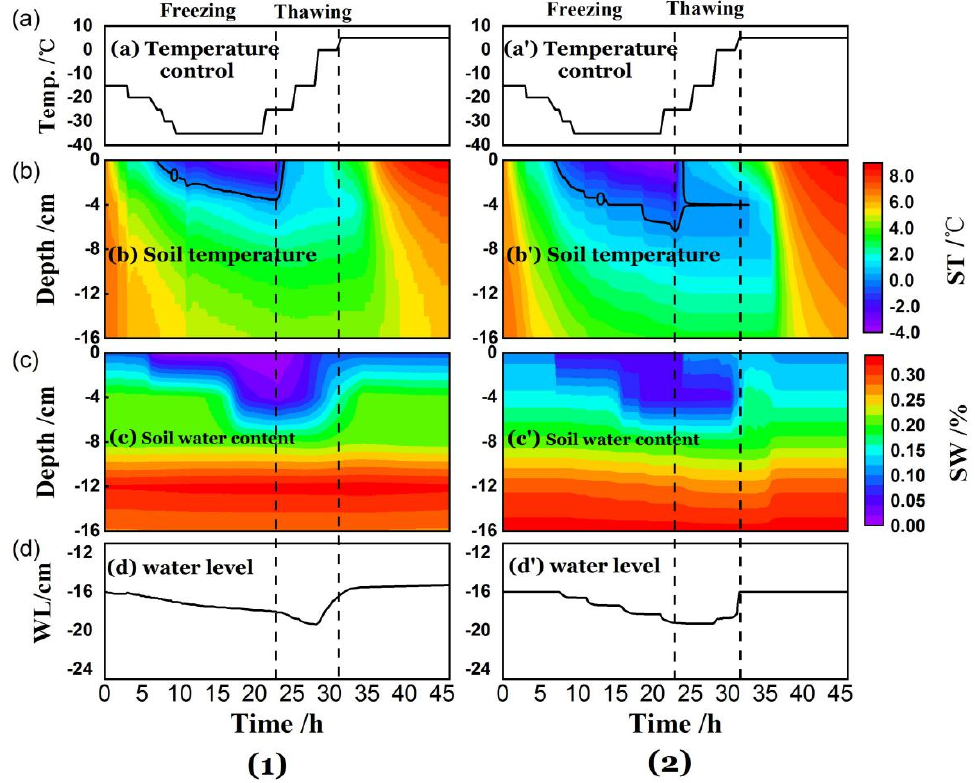
Figure 4. Water and heat transporting results of ( 1 ) medium-sand medium soil column and ( 2 ) Hy- drus-1D model. ( a,a’ ) temperature control process; ( b,b’ ) change of soil temperature; ( c,c’ ) change of soil moisture content; ( d,d’ ) change of groundwater